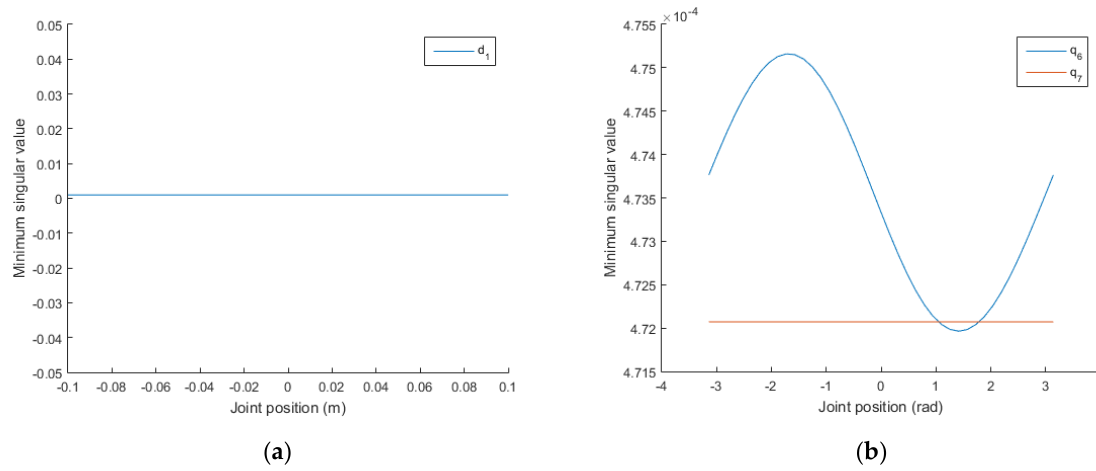
d and ( b ) the distributions of the min- 1 q and q . 6 7